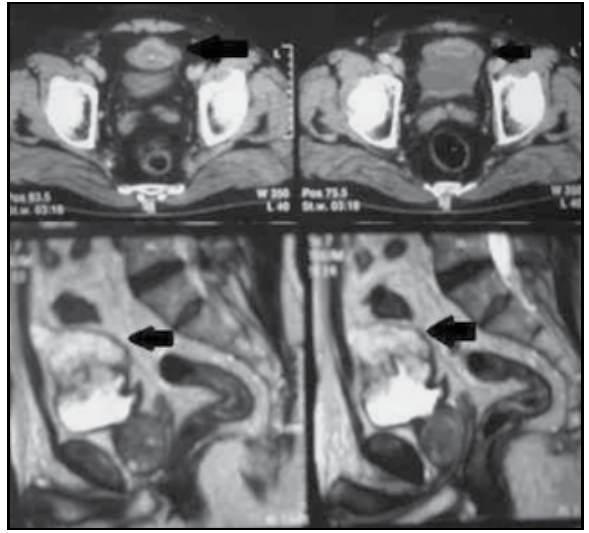
Figura 1 – Bexiga de paredes espessadas e massa junto à cúpula vesical em topografia de úraco (setas) com realce ao meio de contraste. Cortes axiais de TC acima e sagitais de RNM